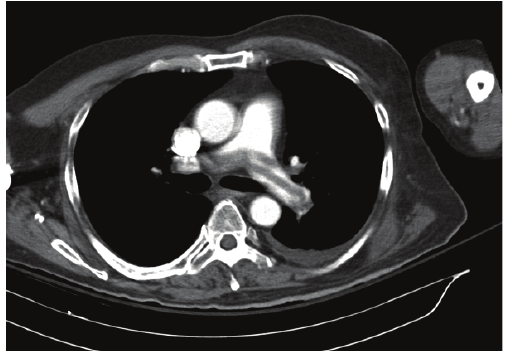
Figure 1: CT pulmonary angiogram showing a large saddle embolus.